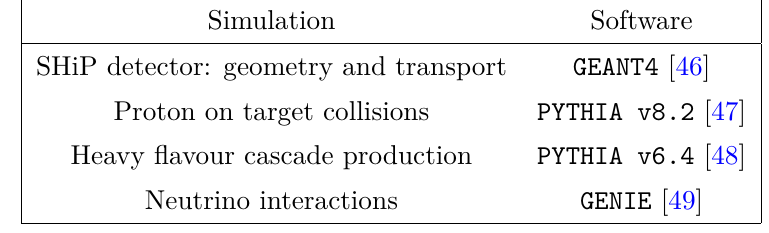
Table 1. Details of the different steps of the simulation process within the FairShip framework and corresponding employed software.